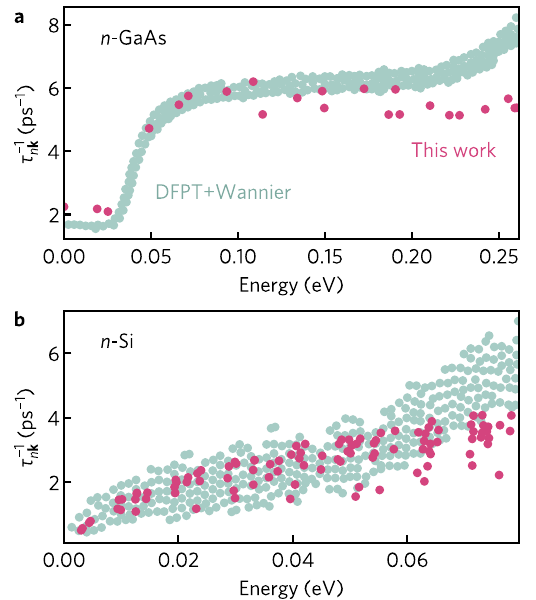
Fig. 1 Calculated scattering rates. Comparison of the calculated (pink) scattering rates, τ (cid:1) 1 n , against those obtained using density functional k perturbation theory combined with Wannier interpolation (DFPT + Wannier, light teal) for ( a ) n -GaAs 44 and ( b ) n -Si 32 at 300 K.